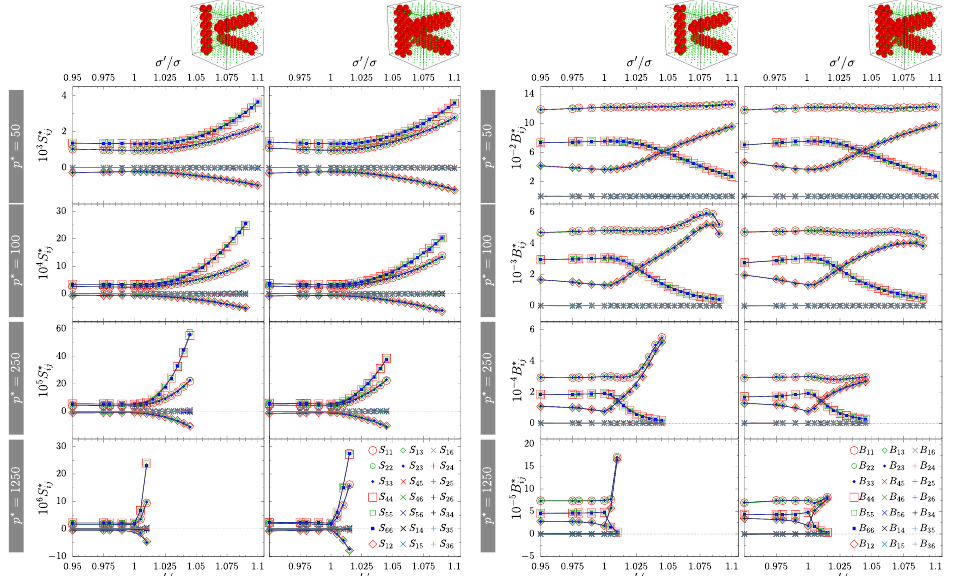
Figure 6. Components of the elastic compliance matrix S ( left ) and matrix of elastic constants B ( right ) for systems with separate D -type and S -type nanochannels. Corresponding values of reduced external pressure p ∗ have been indicated in the figure. The simulation errors of the values are below 3% and they are considerably smaller than the symbols representing them. The quantities represented by cross and plus symbols (x and +) are equal to zero within the computational